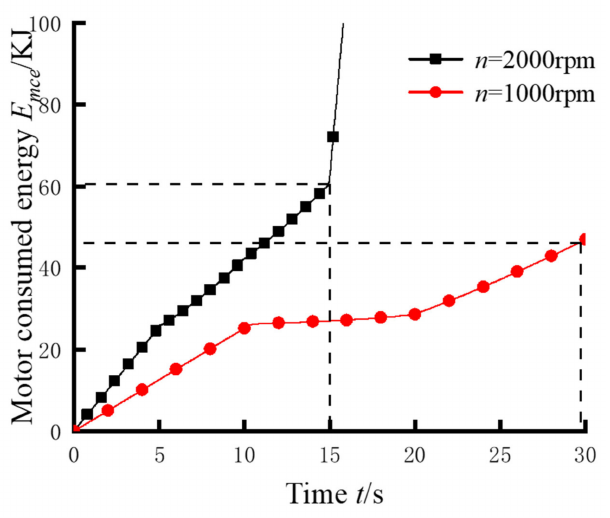
Figure 14. Energy consumption with different speeds.